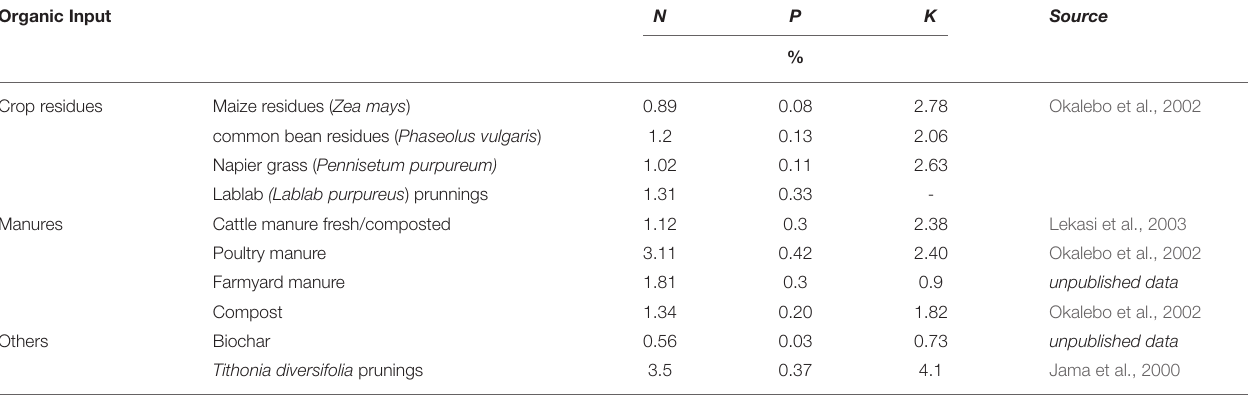
TABLE 2 | Nutrient content of selected organic inputs commonly produced and used on farm for crop production in western Kenya. Organic